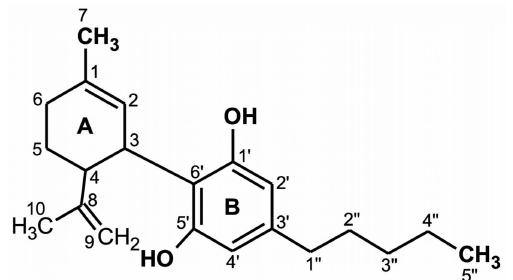
Figure 1. Chemical structure of cannabidiol (CBD) [16].